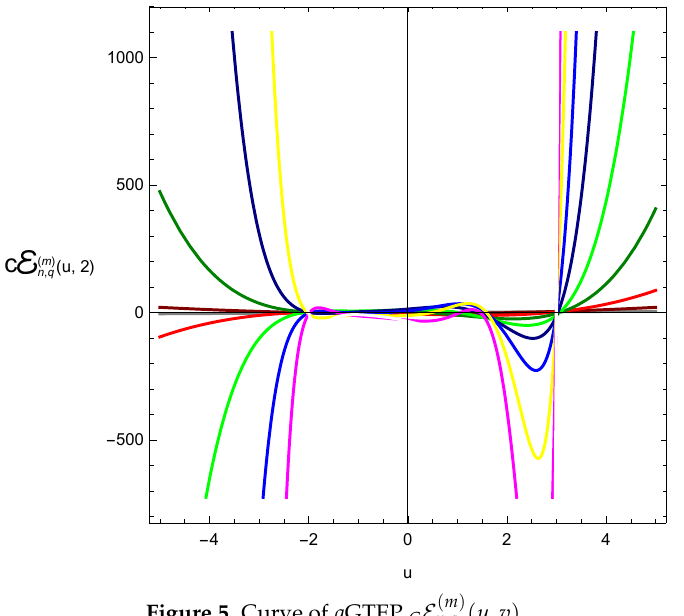
Figure 5. Curve of q GTEP C E